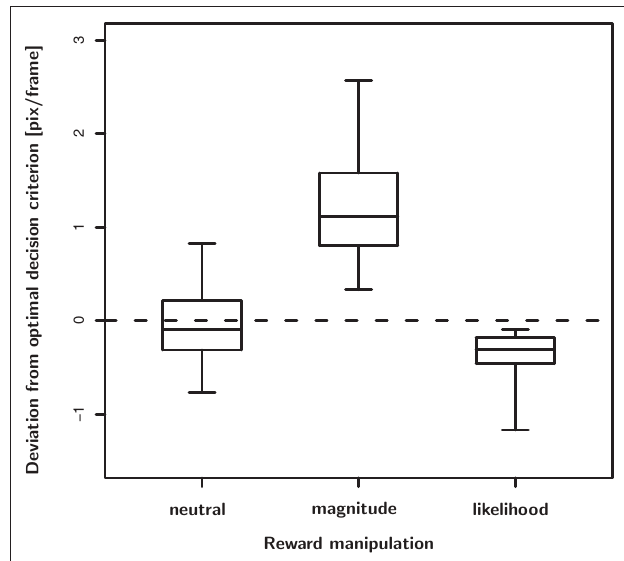
Figure 5 | Deviation from the optimal decision criterion in the neutral, reward magnitude and reward likelihood condition. In the neutral condition there is no systematic deviation from optimality, despite considerable unsystematic variability. In the reward magnitude and the reward likelihood condition we do observes systematic deviation from optimality. In the magnitude bias condition subjects shift their decision criterion too far, i.e., they over-compensate. In contrast, they do not shift their decision criterion far enough in the likelihood bias condition, i.e., they